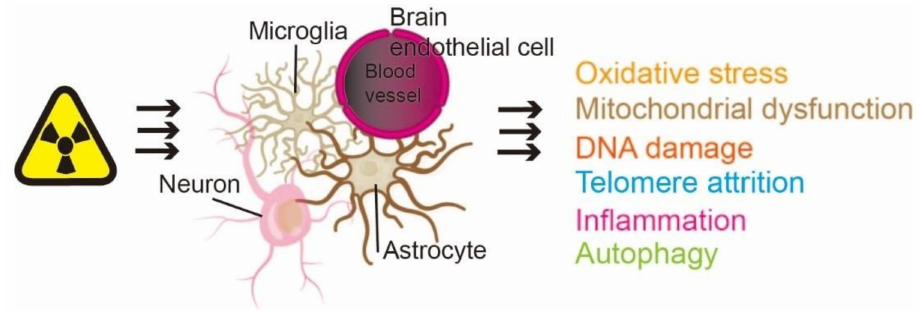
Figure 1. Radiation-induced brain aging includes oxidative stress, mitochondrial dysfunction, DNA damage, telomere attrition, inflammation, and